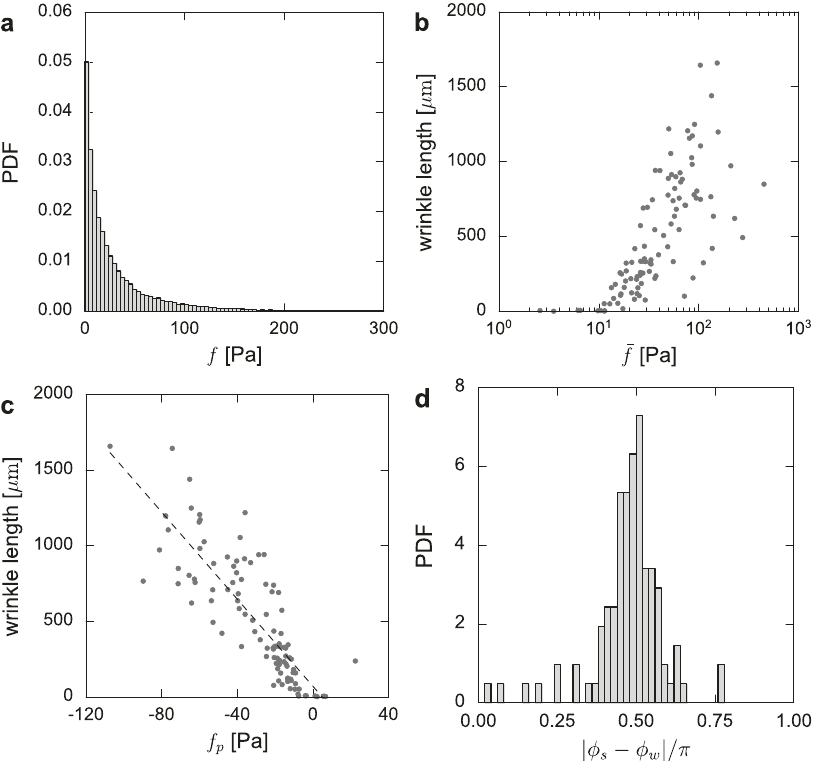
Fig. 3 Quantitative analysis of the traction forces and wrinkles. a Probability distribution function (PDF) of the traction magnitude. b The wrinkle length as the function of the mean traction (cid:1) f . Note that the wrinkle length is evaluated by counting the number of pixels after skeletonizing the wrinkle images. c The wrinkle length as the function of the principal traction f p . d Probability distribution function of the angle differences between the wrinkle direction ϕ w and the traction ϕ s . The fi gure suggests that the direction of the wrinkles is predominantly perpendicular to the principal direction of the force.